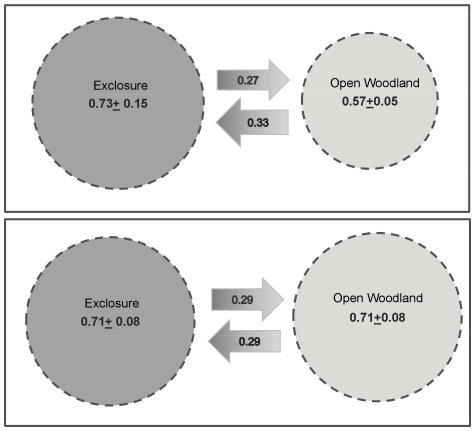
Schematic to show mean probabilities for movement between exclosures and open woodland.Scaled schematic showing probability of staying in same state (exclosure or open woodland) as that in which first encountered (circles) and probability of moving between states dependent on state in which first encountered in (arrows). Values shown are mean model averaged parameter estimates from the three sites with standard error in brackets.